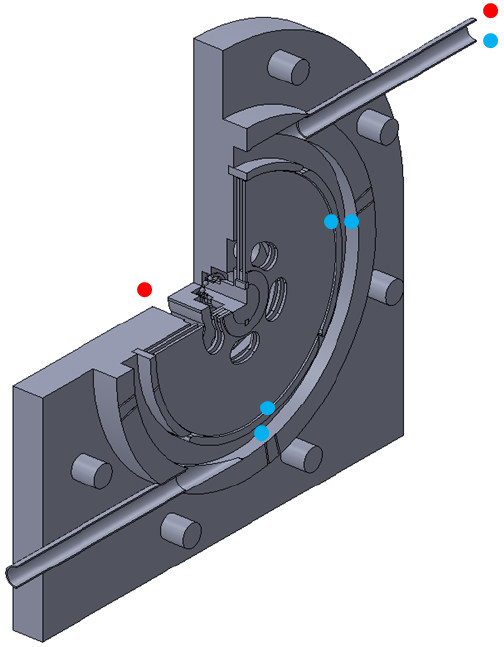
Figure 5. Location of sensors: temperature (red dots) and pressure (blue dots). The measurement procedure started with setting a demanded load on the generator. Then, the pressure level was adjusted by means of the control valves in the air tank. Due